Question: Draft a figure caption describing what is shown.
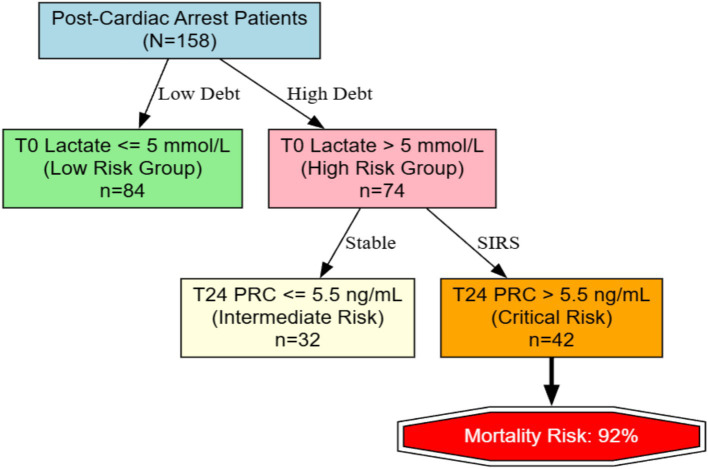
Answer: Prognostic decision tree for in-hospital mortality. The CART model illustrates the synergistic interaction between early metabolic debt (T0 lactate) and subsequent systemic inflammatory response (T24 PCT). Patients exceeding both thresholds (> 5 mmol/L and > 5.5 ng/mL, respectively) represent the highest risk cohort with a 92% mortality rate.